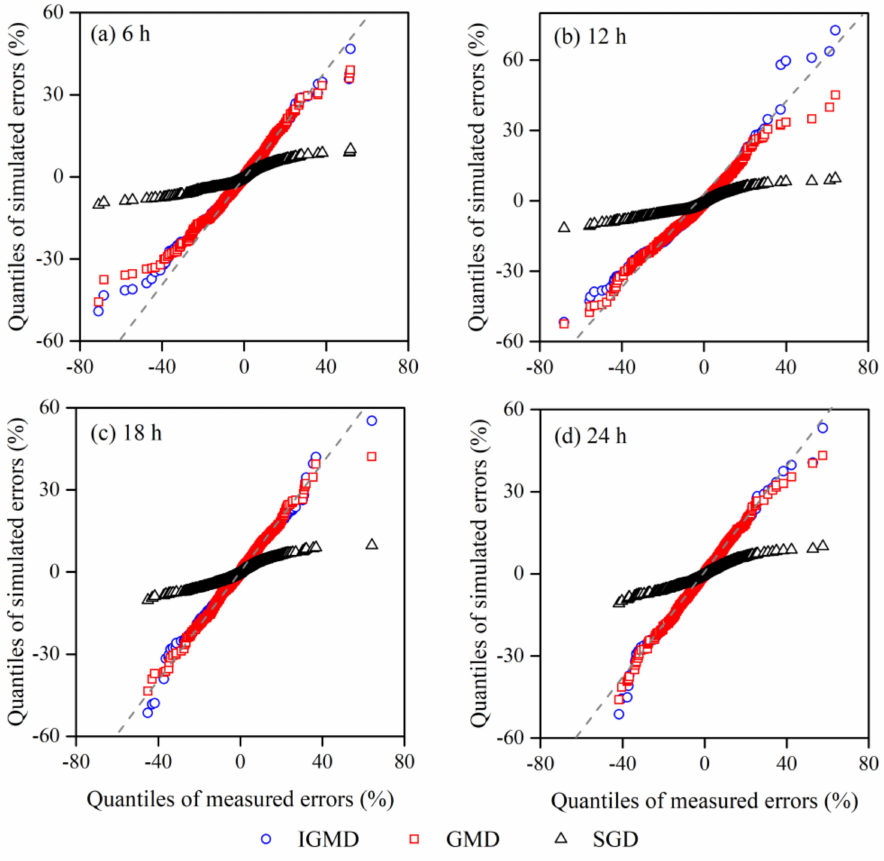
Figure 5. Q–Q plots of the simulated and measured forecast errors generated from the IGMD, GMD, and SGD models under different sub-daily lead times. The gray short-dash line in each of the subplots represents the 1:1 line for the two coordinate axes. Table 2. Statistics of the sampled errors based on the IGMD and GMD models vs. the measured errors.